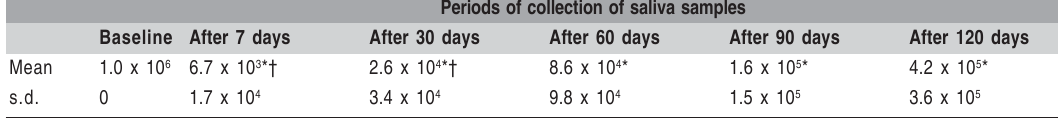
Table 2: Means and standard deviations of salivary MS levels (CFU mL -1 of saliva) before (baseline) and 7, 30, 60, 90 and 120 days after application of the CHX gel containing aspartame (n = 9 subjects).